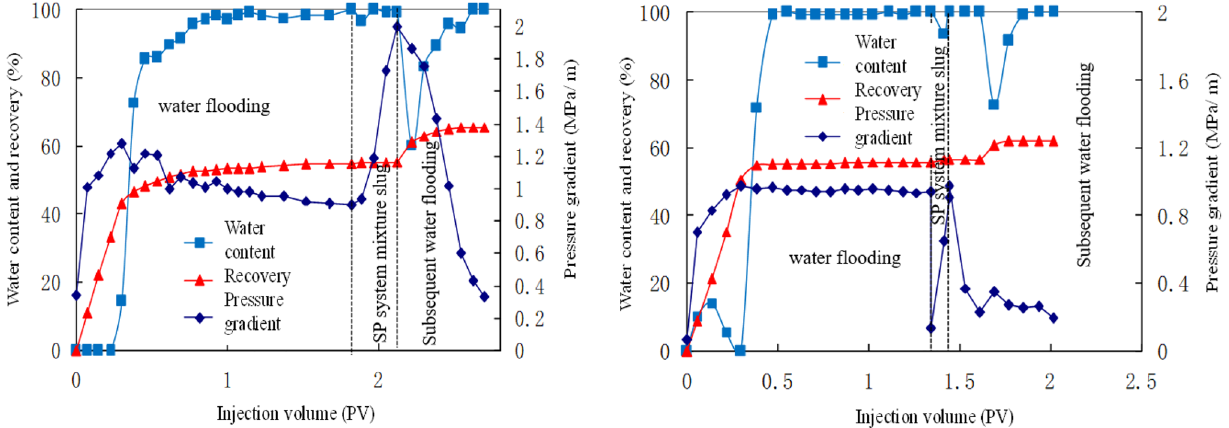
Fig. 15 Core flooding experiment results of 0.3PV(left) and 0.1PV(right) mixture